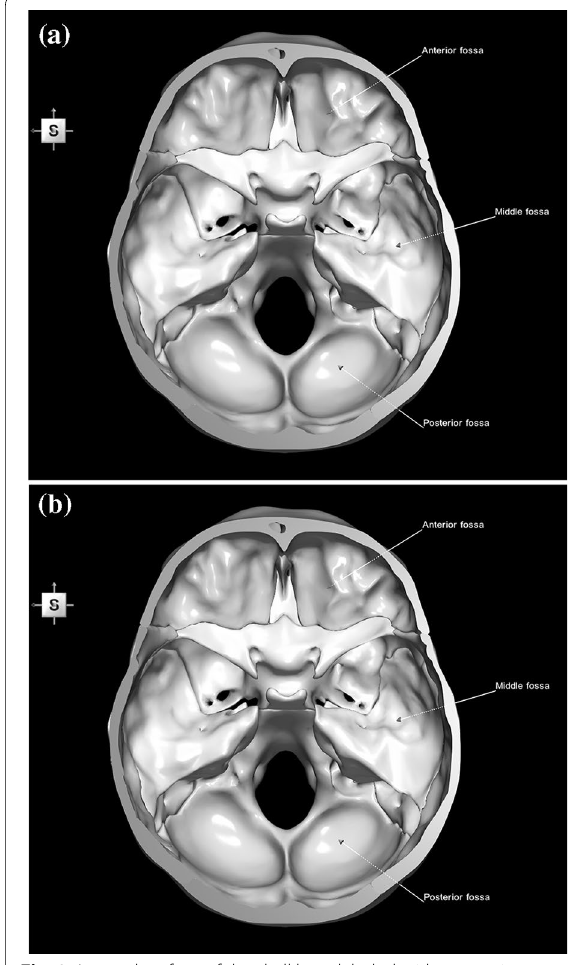
Fig. 2 Internal surface of the skull base labeled with: a anterior, middle and posterior fossa; b color-coded five